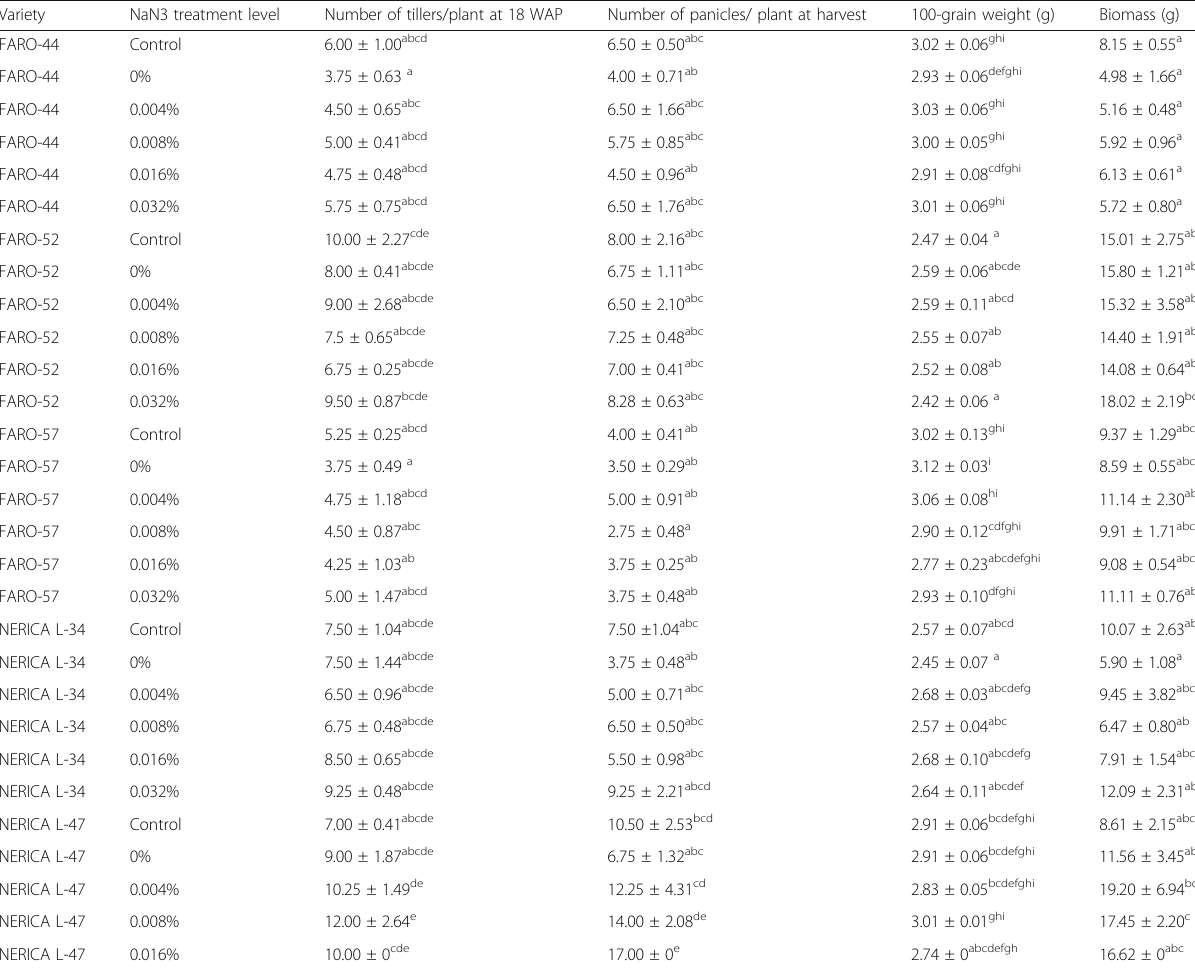
Table 7 Yield parameters of the five varieties